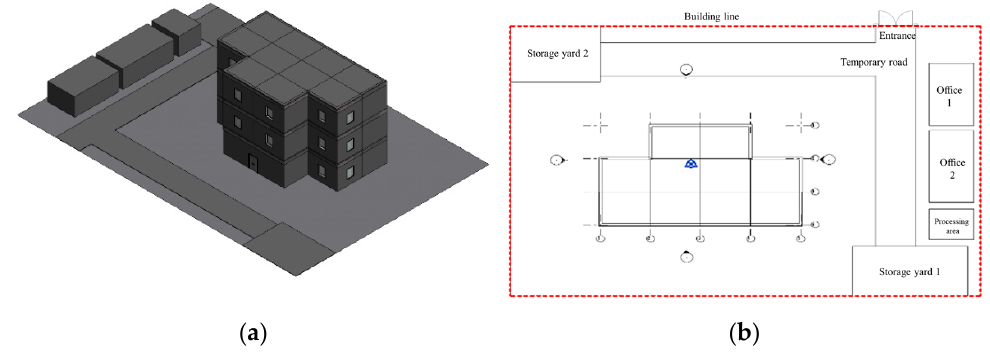
Figure 6. BIM model and site layout ( a ) BIM model of the building with precast components. ( b ) Roads and temporary facilities in the construction site layout. Table 5. Basic performances of the candidate cranes in the database.